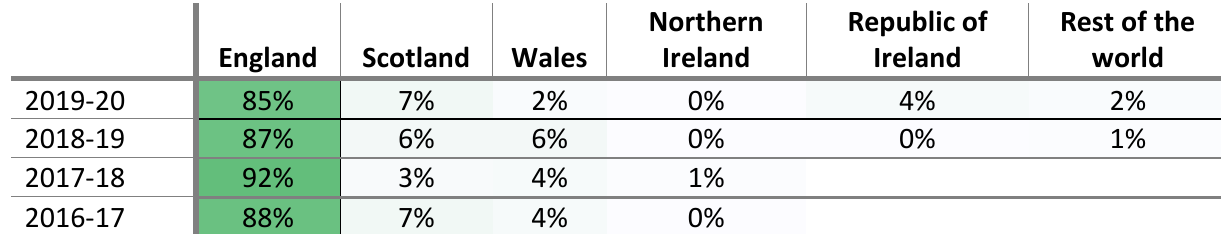
Table 10: Turnover originating from work undertaken by UK-headquartered organisations in each of these locations from 2017 to 2020.